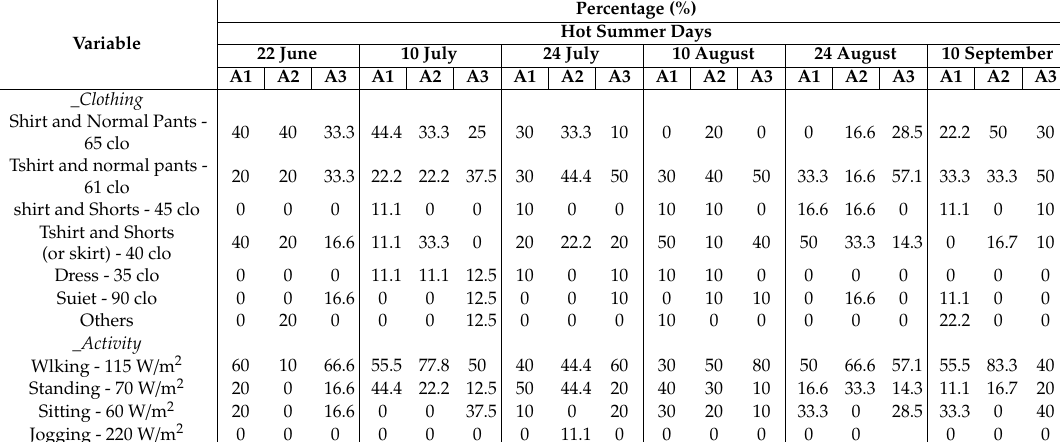
Table 4. Clothing and activity level of responders in the three investigated intersections.